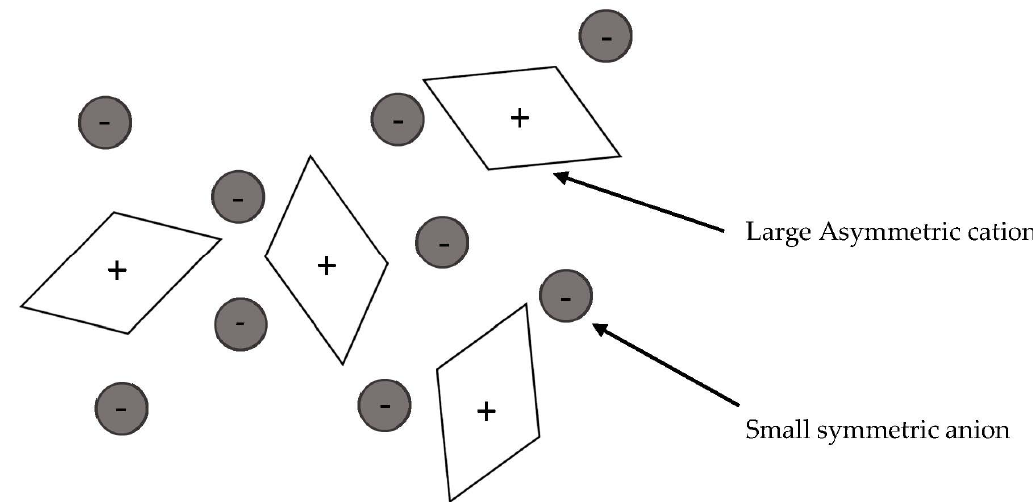
Figure 1. Schematic showing the structure of an ionic liquid.